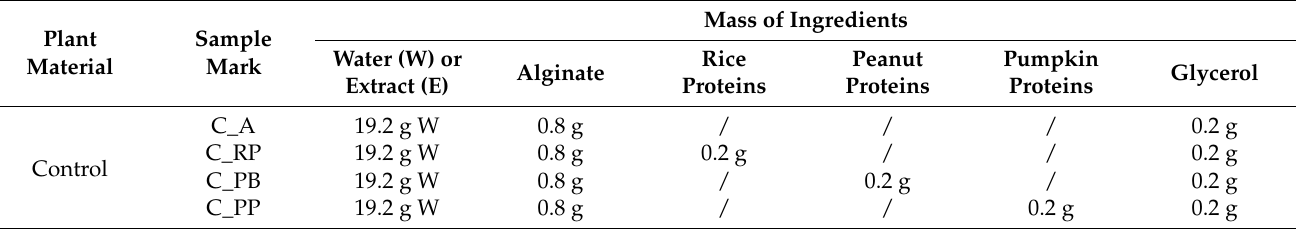
Table 1. Formulations of edible